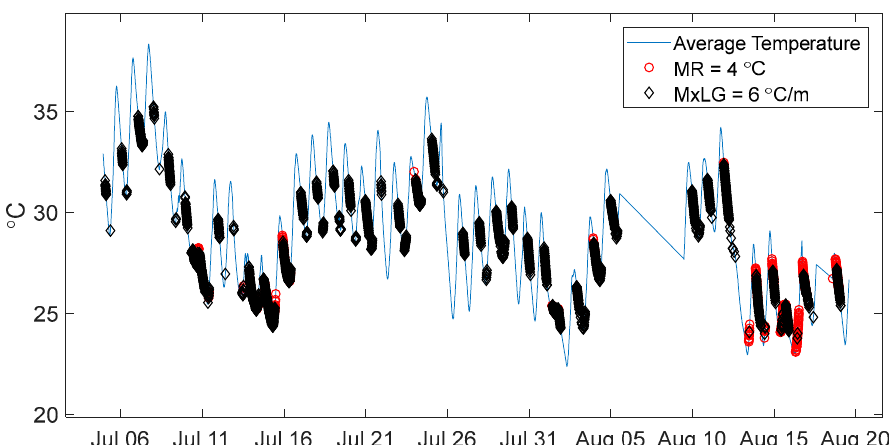
Figure 16. Summer 2010 Streicker Bridge minimal thermal gradient methods comparison.